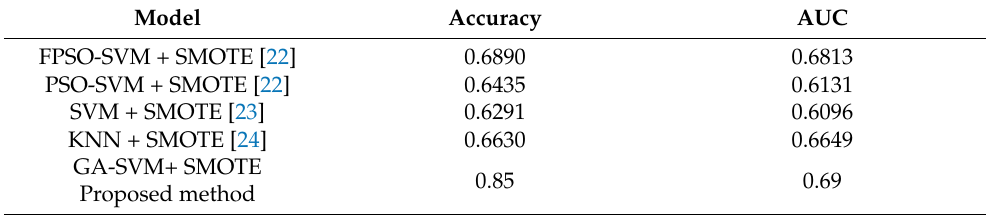
Table 4. Accuracy and AUC comparison for different algorithms on the Haberman dataset.